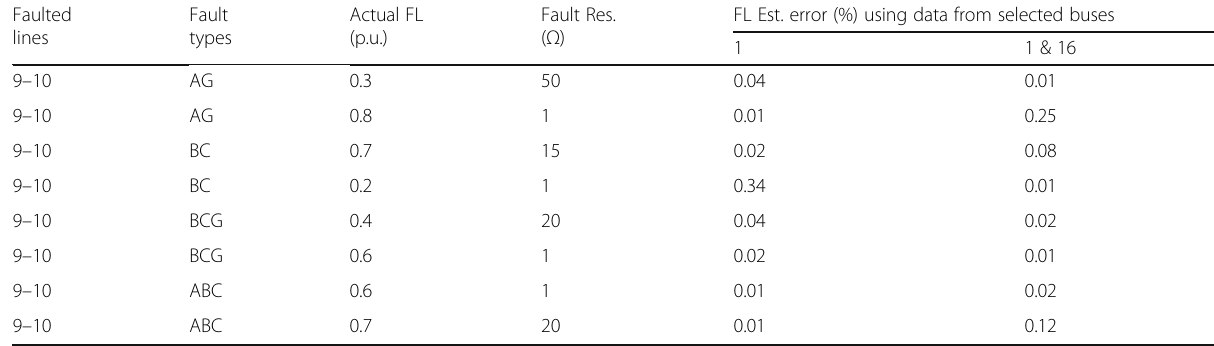
Table 8 Fault location results for single faults on untransposed line Faulted lines